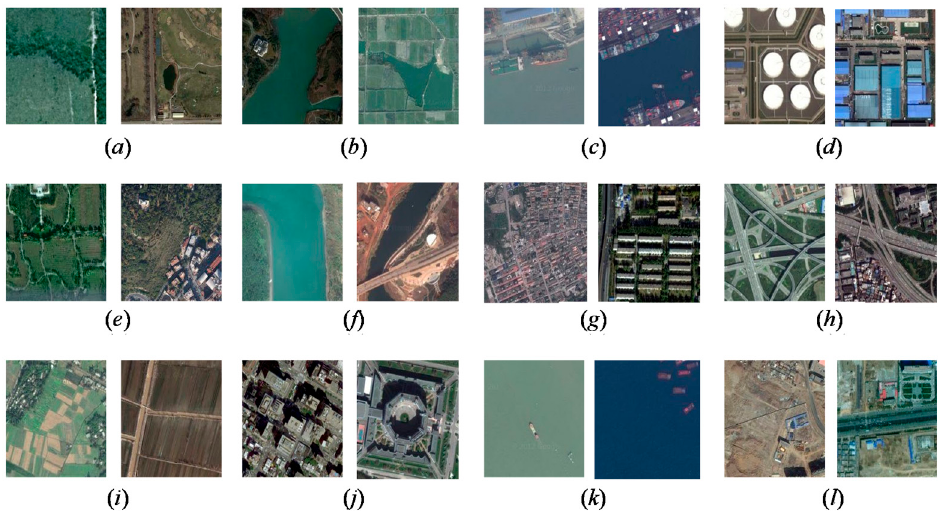
Figure 6. Representative images of the Google Image dataset of SIRI-WHU: ( a ) meadow; ( b ) pond; ( c ) harbor; ( d ) industrial; ( e ) park; ( f ) river; ( g ) residential; ( h ) overpass; ( i ) agriculture; ( j ) commercial; ( k ) water; ( l ) idle land.